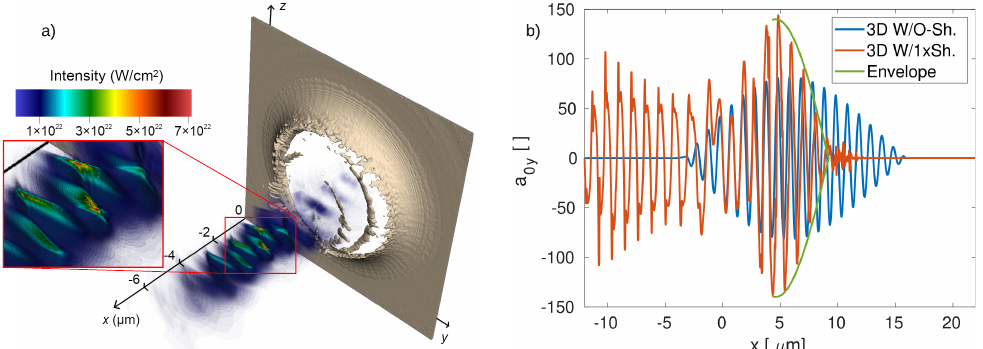
Figure 9. Plasma shutter. ( a ) The distribution of the laser intensity in the horizontal slice of the laser pulse from 3D simulation with the plasma shutter when the maximum intensity value is reached, source [78]. ( b ) The 1D profile (at y = 0 and z = 0) of dimensionless amplitude of the electric field in the y -direction ( a 0 y ) after the laser pulse propagates through the plasma shutter in the 3D simulation. Comparison of the transmitted laser pulse (W/1xSh) with the original one (W/O–Sh). Steep front is generated, its envelope is approximated using the equation y = 140 · sin ( π · x /9.2 ) . Source [79]. Figures reprinted under the terms of the Creative Commons Attribution